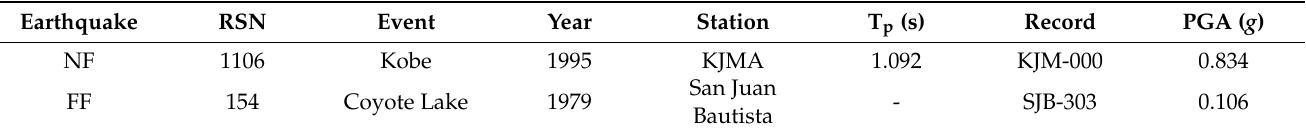
Table 3. Details of near-fault and far-fault earthquake